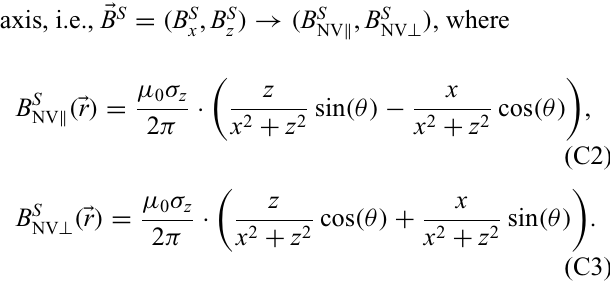
FIG. 9. Additional dc and ac measurements of CrBr 3 flakes. (a),(b) Hysteresis curves for Flake C (a) and Flake D (b) measured at 4 = 2 mT. The simultaneously measured dc magnetization ( ∝ − B S K. (c) Field-cooling ac susceptibility χ ac (blue) for Flake D at B E dc is shown in red on the same plot. (d),(e) Hysteresis curves for Flake E measured at two different locations along the edge, as indicated in Fig. 8(e). (f) Extended linecut of the stray field across the right edge ( x = 0) of Flake E that directly locates domain walls. Domains = 76 mT are shaded in red aligned (antialigned) with the bias field B E dc